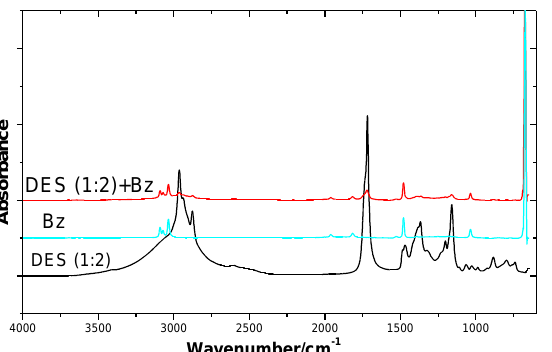
Figure 16. FT−IR spectra of DES(1:2), benzene and DES(1:2) + benzene(DES 0.1 (molar concentra- tion)).